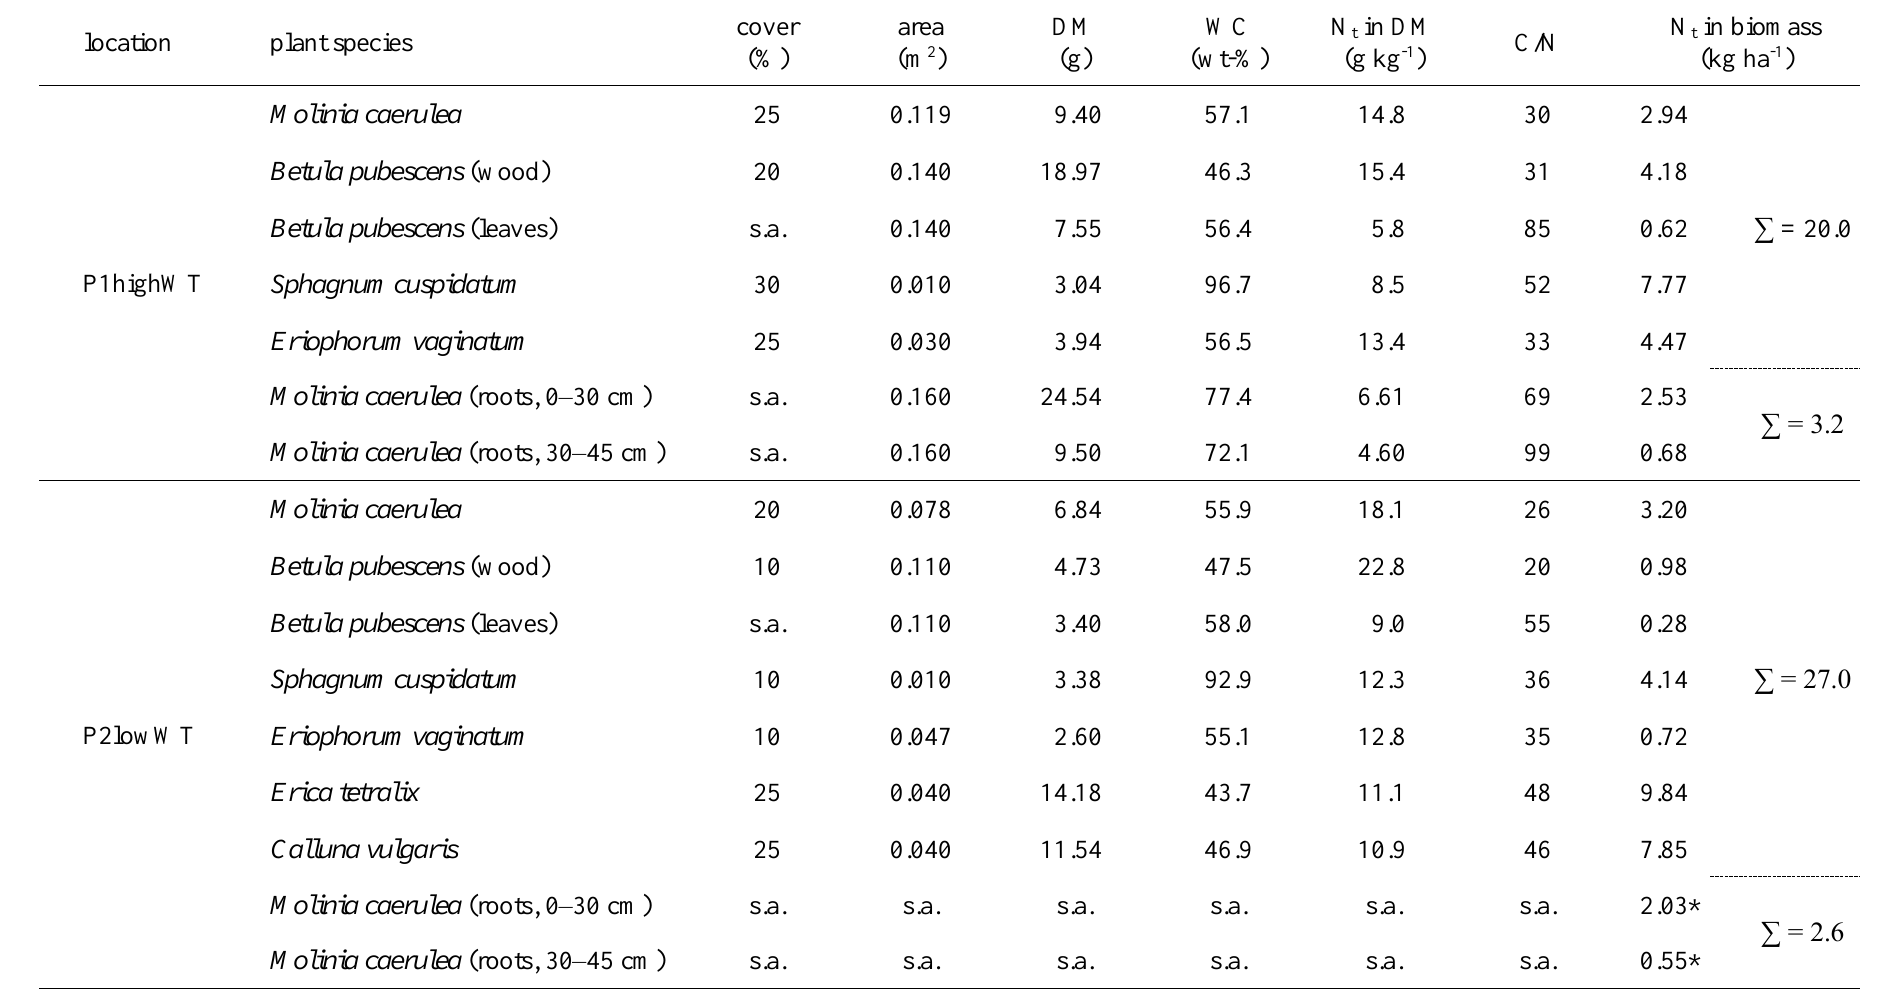
Table 1. Measured attributes of vegetation (mean values), for calculation see Equation 1 in the Methods section. DM = dry mass, WC = water content (gravimetric), A = area sampled, s.a. = see above. Roots of Molinia caerulea were sampled at P1highWT only, and the results were extrapolated (*) to P2lowWT.